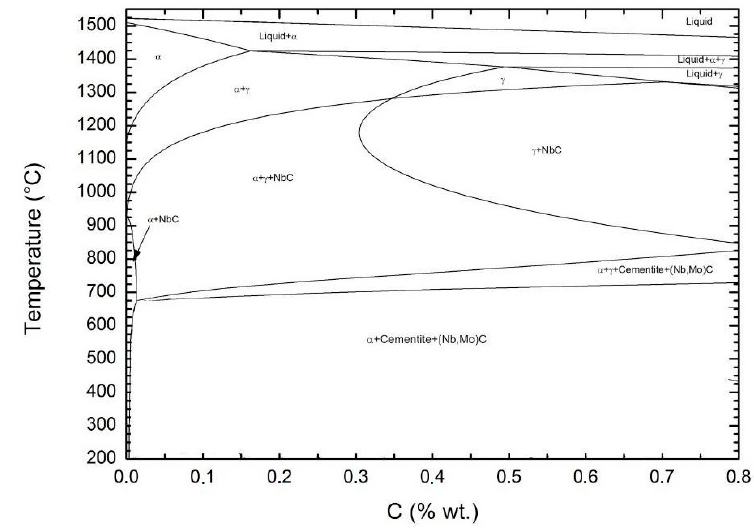
Figure 1. Pseudobinary Fe-C phase diagram of 3 Mn steel determined using Thermo-Calc.